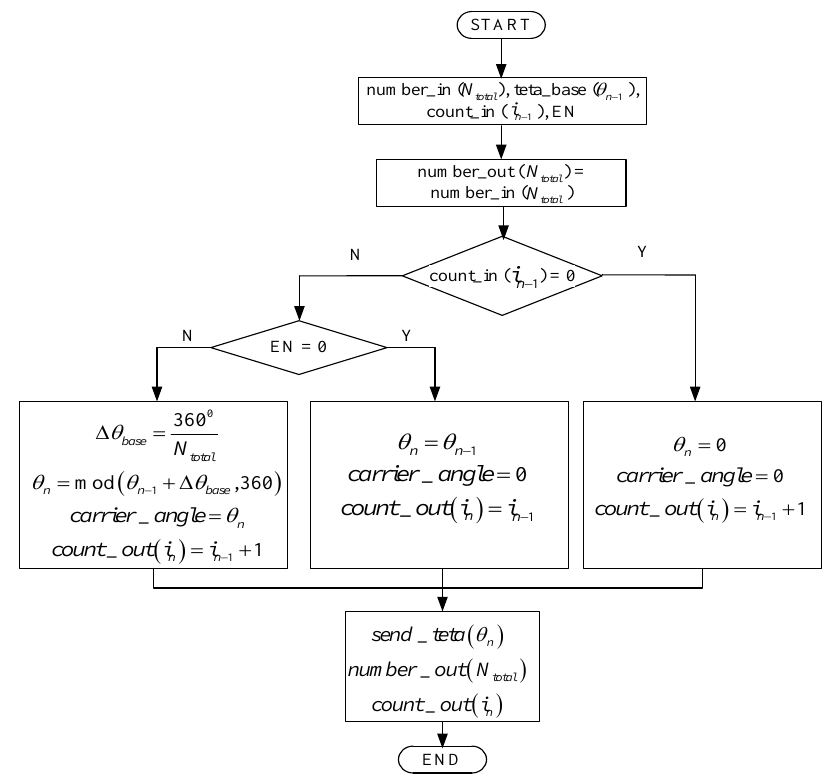
Figure 6. Algorithm flowchart of the proposed DSA-PSC method.